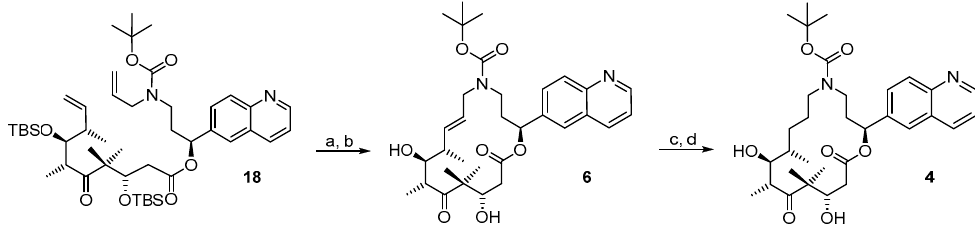
Figure 3. Molecular structure of azathilone 19